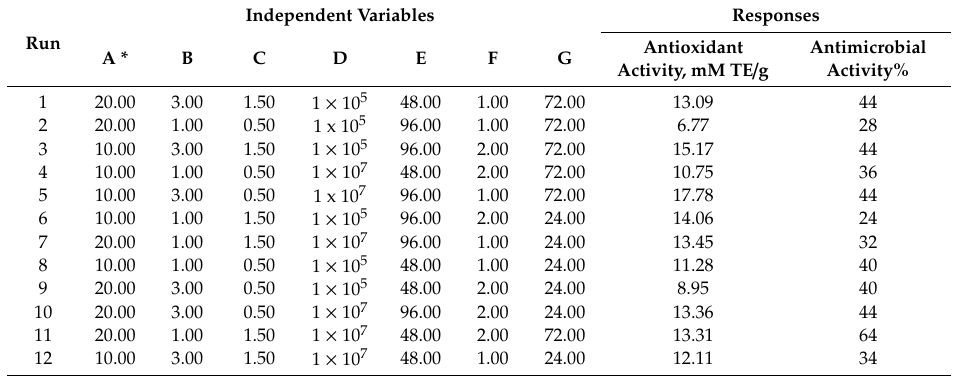
Table 4. Placket–Burman experimental design for the screening of the most significant variables upon Solid State Fermentation (SSF)